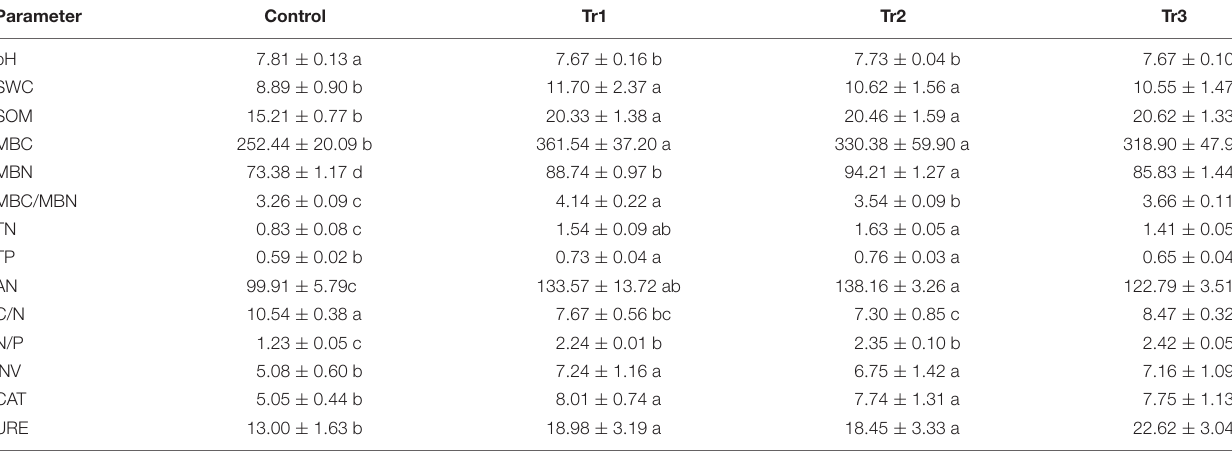
TABLE 1 | Basic physicochemical parameters, soil nutrient contents, and enzyme activities in treated and control soil.